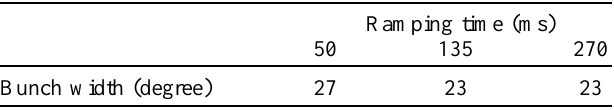
TABLE III. Captured bunch widths for various ramping times.